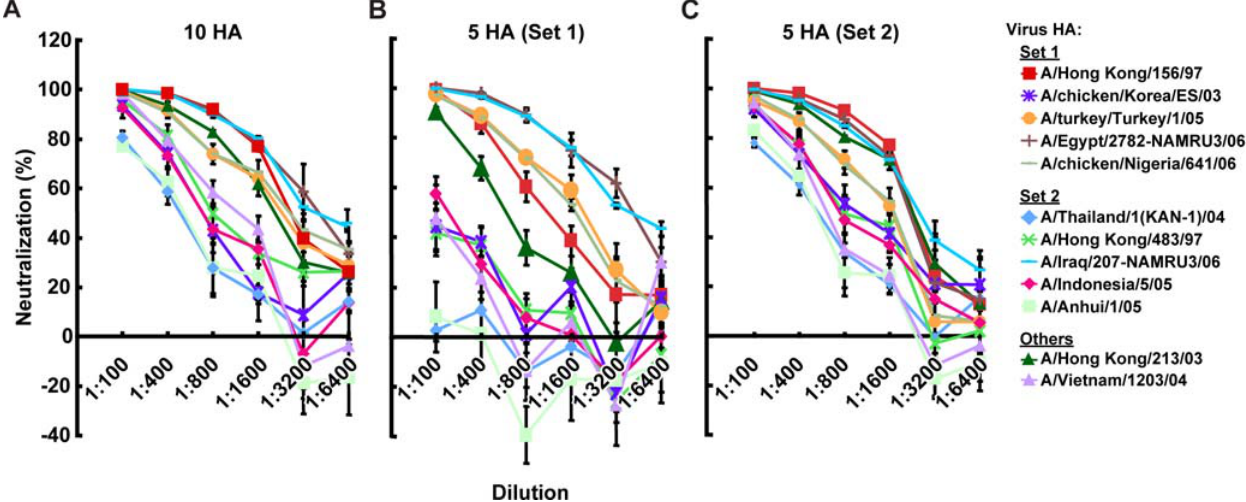
Figure 2. Breadth of neutralization against divergent HAs is determined by the composition of multivalent HA plasmid DNA expression vectors. Neutralization of 12 different H5N1 isolates was determined in the LAI assay using serum from mice immunized with (A) 10 HAs comprised of: pCMV/R 8 k B-HA(A/Hong Kong/156/1997), pCMV/R 8 k B-HA(A/chicken/Korea/ES/2003), pCMV/R 8 k B-HA(A/turkey/Turkey/1/2005), pCMV/R 8 k B-HA(A/Egypt/2782-NAMRU3/2006), pCMV/R 8 k B-HA(A/chicken/Nigeria/641/2006), pCMV/R 8 k B-HA(A/Indonesia/05/2005), pCMV/R 8 k B- HA(A/Anhui/1/2005), pCMV/R 8 k B-HA(A/Thailand/1(KAN-1)/2004), pCMV/R 8 k B-HA(A/Hong Kong/483/1997), and pCMV/R 8 k B-HA(A/Iraq/207- NAMRU3/2006) as in 5 HA (Set 1) plus in 5 HA (Set 2). (B) 5 HA (Set 1) composed of vectors: pCMV/R 8 k B-HA(A/Hong Kong/156/1997), pCMV/R 8 k B- HA(A/chicken/Korea/ES/2003), pCMV/R 8 k B-HA(A/turkey/Turkey/1/2005), pCMV/R 8 k B-HA(A/Egypt/2782-NAMRU3/2006), and pCMV/R 8 k B-HA(A/ chicken/Nigeria/641/2006)., or (C) 5 HA (Set 2) contained: pCMV/R 8 k B-HA(A/Indonesia/05/2005), pCMV/R 8 k B-HA(A/Anhui/1/2005), pCMV/R 8 k B- HA(A/Thailand/1(KAN-1)/2004), pCMV/R 8 k B-HA(A/Hong Kong/483/1997), and pCMV/R 8 k B-HA(A/Iraq/207-NAMRU3/2006). Mice were vaccinated as described in Materials and Methods. In this experiment, the DNA vaccine consisted of 10 plasmids (1.5 m g each) expressing HA proteins as indicated. In panels B and C, mice (n=10) were immunized with 15 m g of plasmid (3 m g each) three times at 3 week intervals. Serum pools from the immunized animals were collected 14 days after the third immunization. The antisera were tested against the 12 indicated pseudotyped lentiviral vectors at varying dilutions. Error bars at each point indicate the standard deviation; each sample was evaluated in triplicate. In general, the immunized serum neutralized all tested pseudotyped lentiviruses at low dilutions while differences were often observed at high dilution.